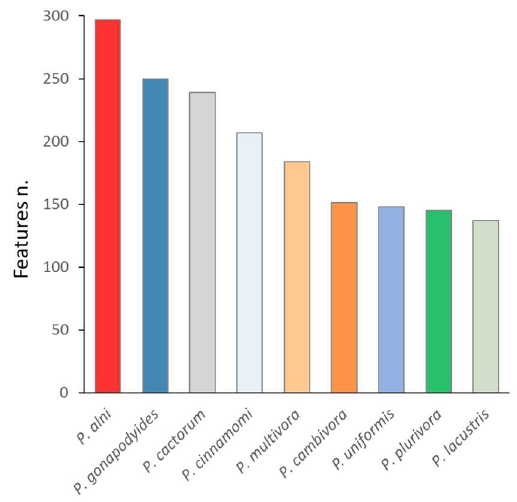
Figure 2. Species-specific patterns found in mycelium proteomes. Number of identified features showing statistically significant differences (Kruskal–Wallis test, p < 0.05) in contrast to all other analyzed species with at least three different isolates. Color corresponds to individual species (Figure 1). See Supplementary Table S2 for details.